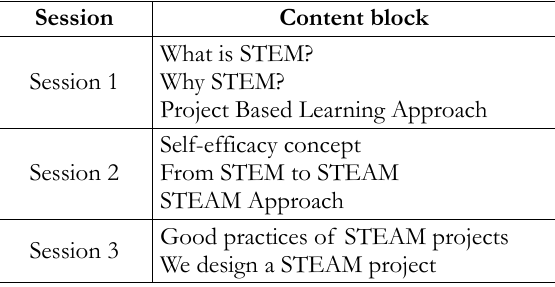
Table 1. Structure of the STEAM